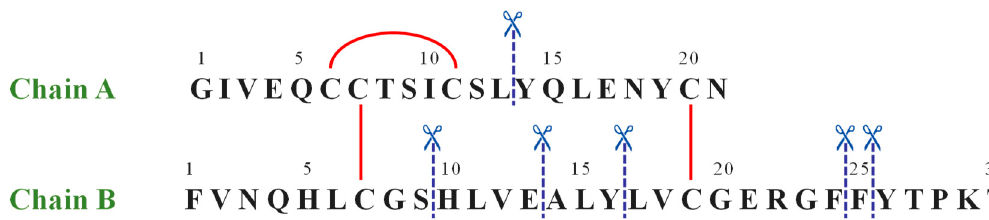
Figure 1. The amino acid sequence of human insulin. The red straight lines show intra- and inter-chain disulfide bridges, whereas the blue dashed lines label the IDE-catalyzed cleavage sites.